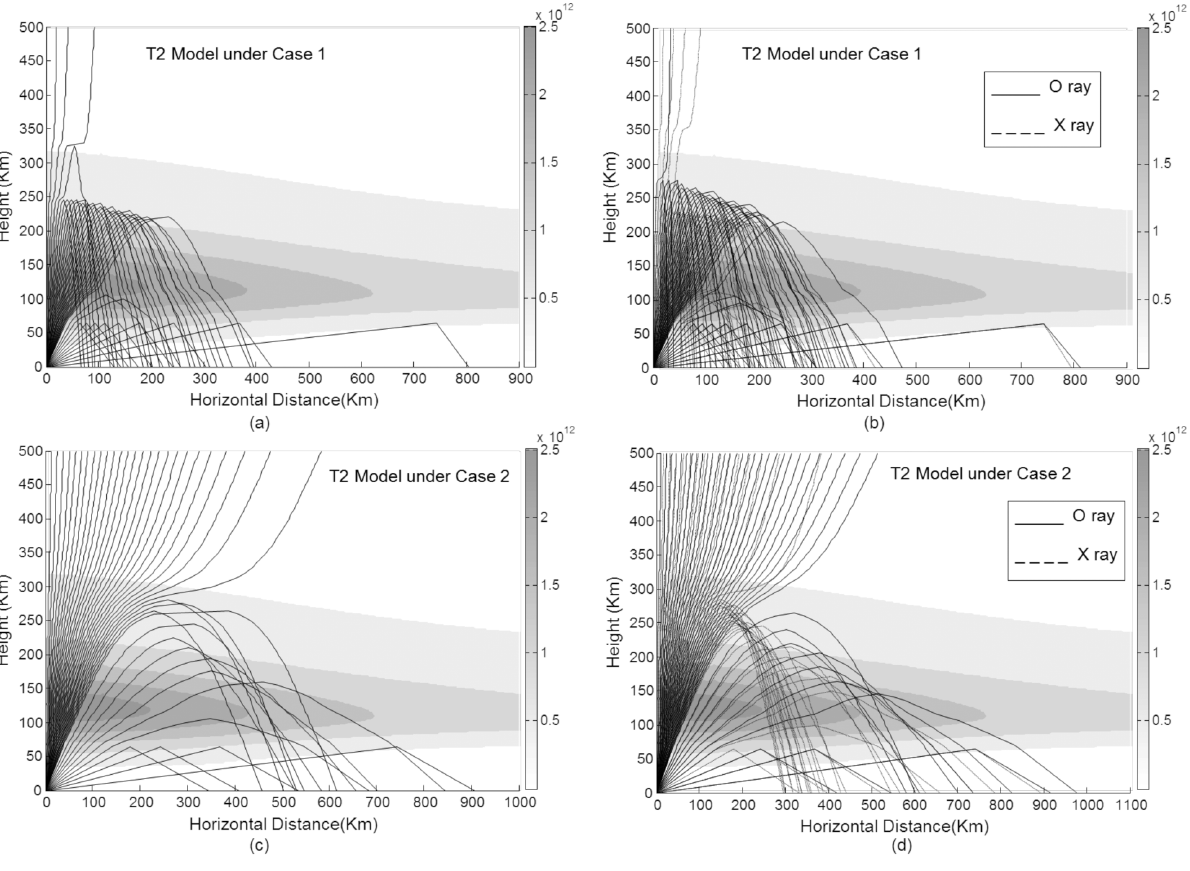
Figure 7. Ray tracing for different angle of incidence with frequency 7.5 MHz using the T2 model of the ionosphere: (a) without influence of magnetic field under Case 1, (b) with influence of magnetic field under Case 1, (c) without influence of magnetic field under Case 2, (d) with influence of magnetic field under Case